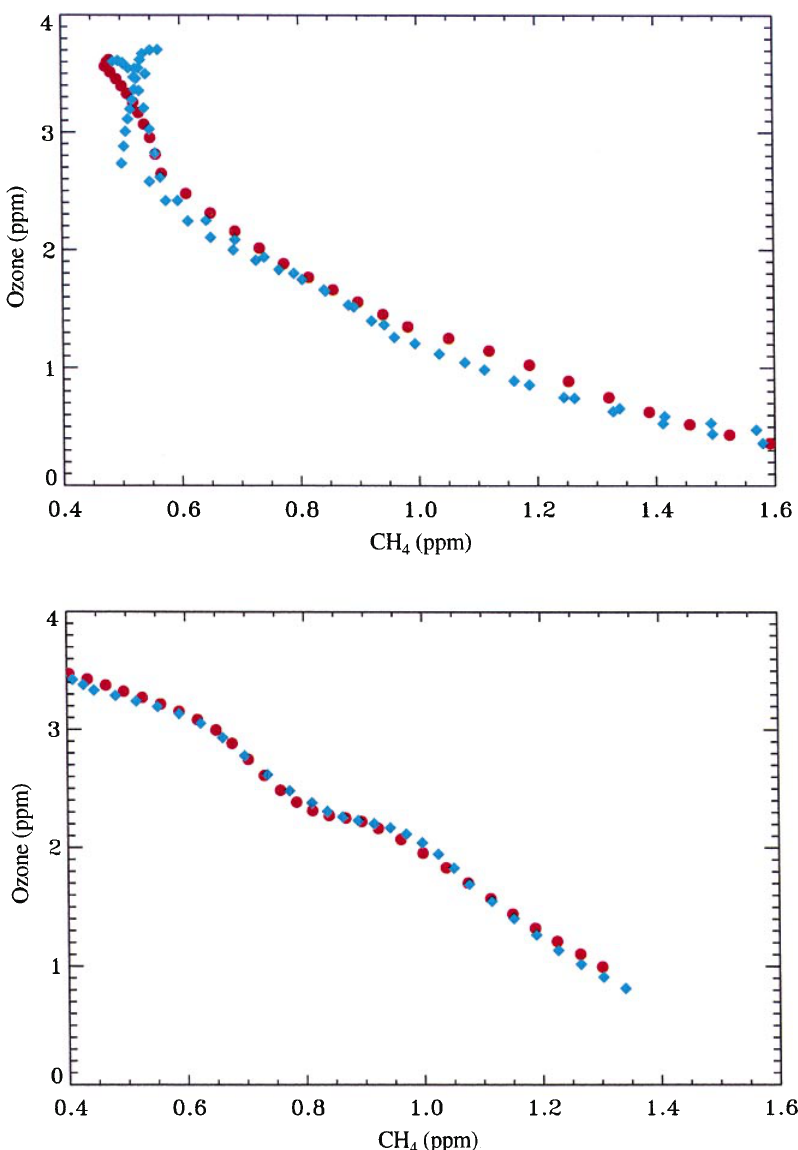
Fig. 13. As Fig. 12, but showing the relation of